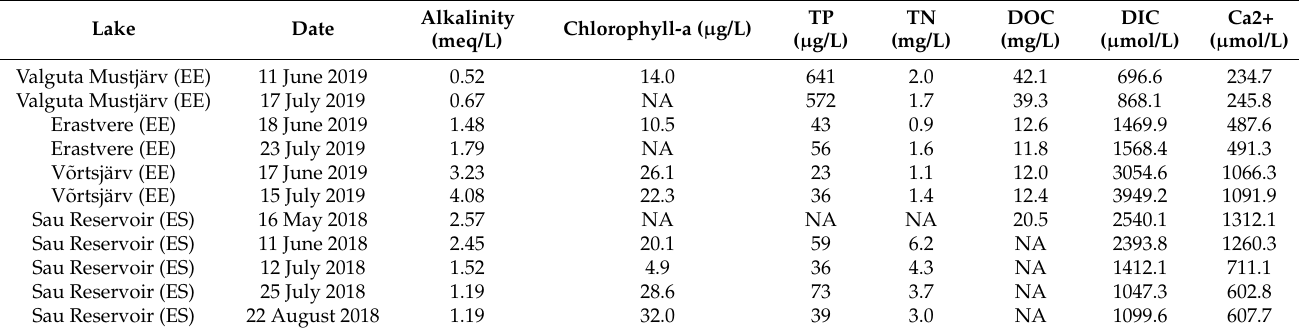
Table A1. Ancillary data of the studied lakes.